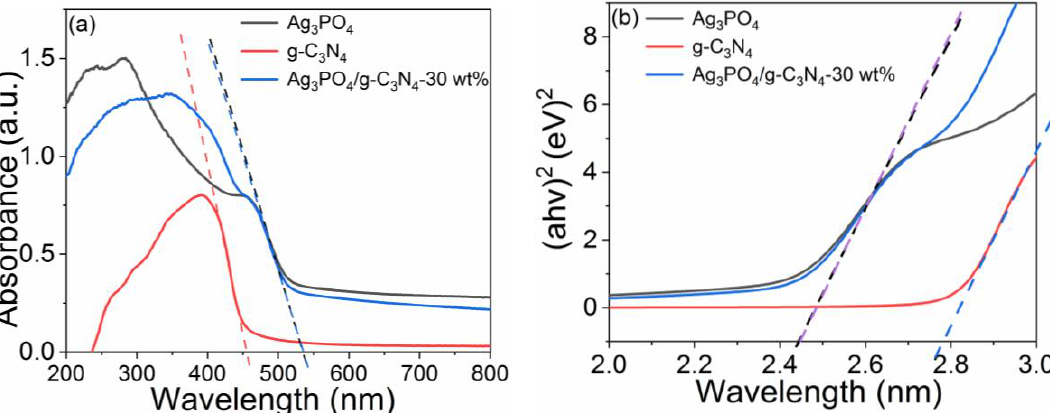
Figure 3. ( a ) UV-vis diffuse reflectance spectra, ( b ) estimated bandgap of Ag 3 PO 4 , g-C 3 N 4 , and Ag 3 PO 4 /g-C 3 N 4 -30